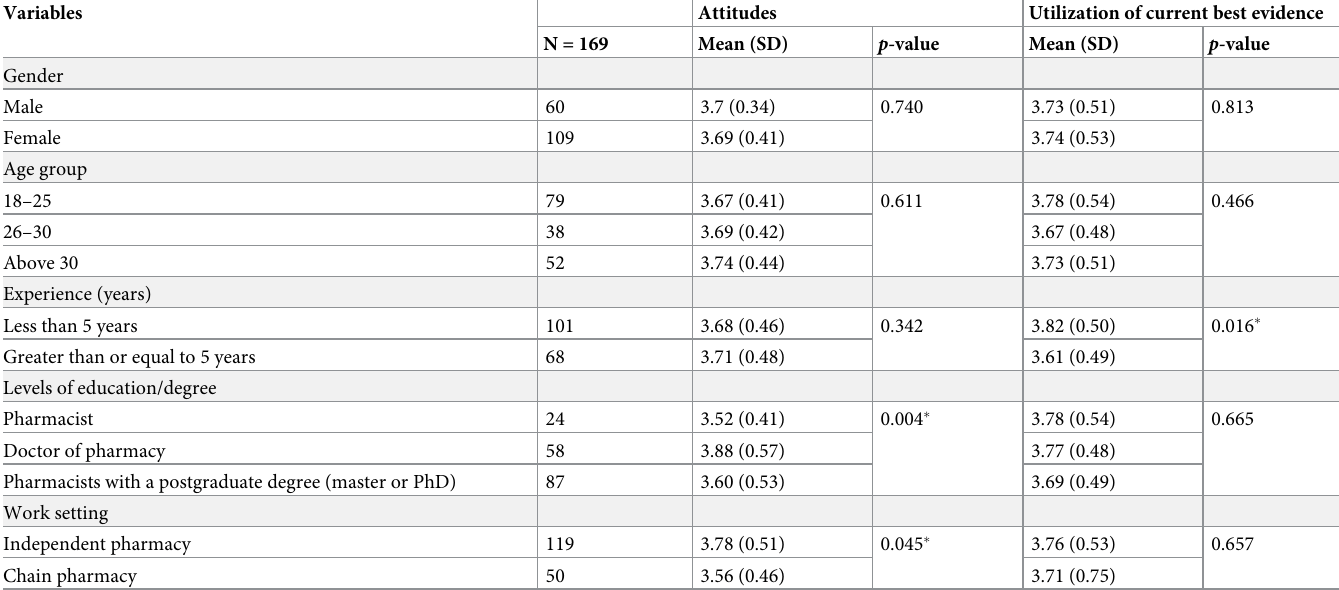
Table 4. T-test and F-test for pharmacists’ attitudes toward practice-based research and their utilization of current best evidence by sociodemographic characteristics.